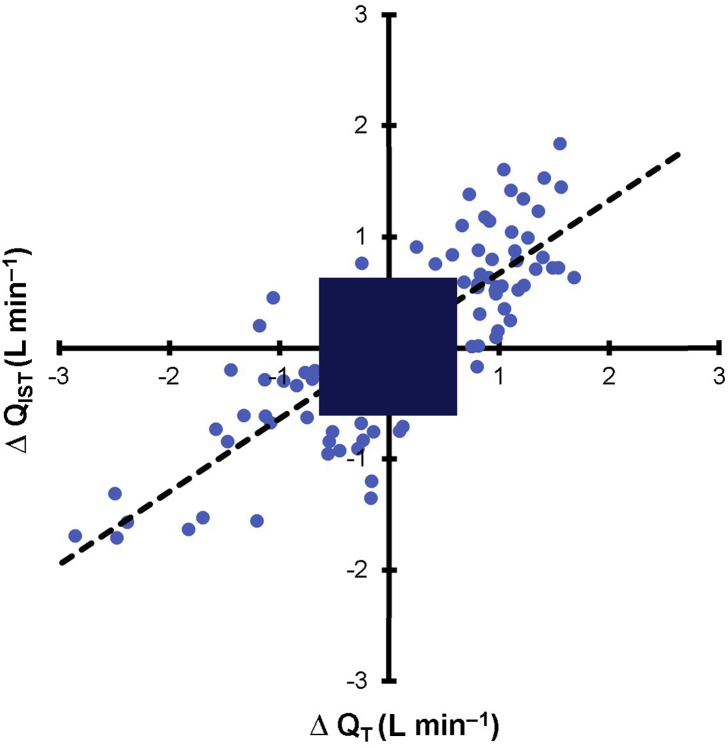
Four-quadrant plot analysis of ΔQ˙ISTvs ΔQ˙T throughout the protocol, with an exclusion zone of 15% mean Q˙ (0.67 L min−1). Linear regression analysis reveals an equation of ΔQ˙IST=0.65×ΔQ˙T+0.01, where r=0.84. Data points located in either quadrant of agreement were considered concordant (92.5%).